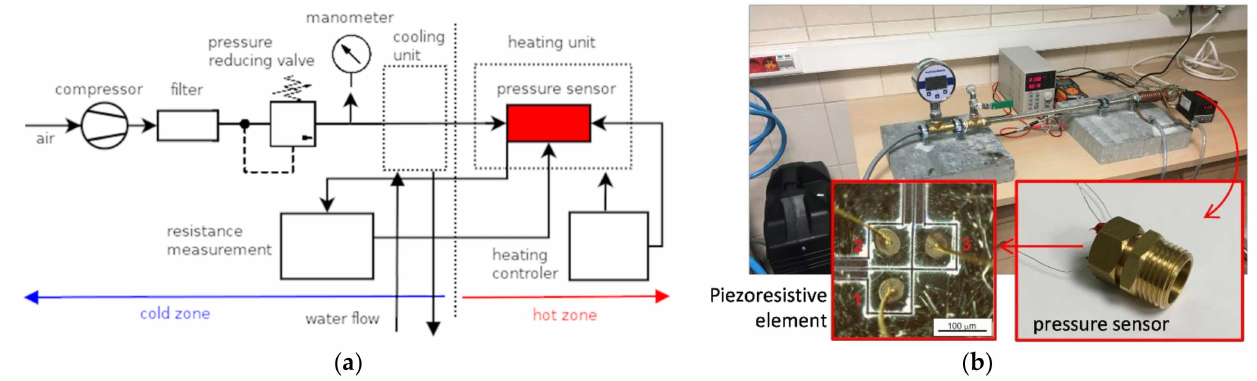
Figure 8. The schematic diagram ( a ) and the stage for characterization of the piezoresistive pressure sensors ( b